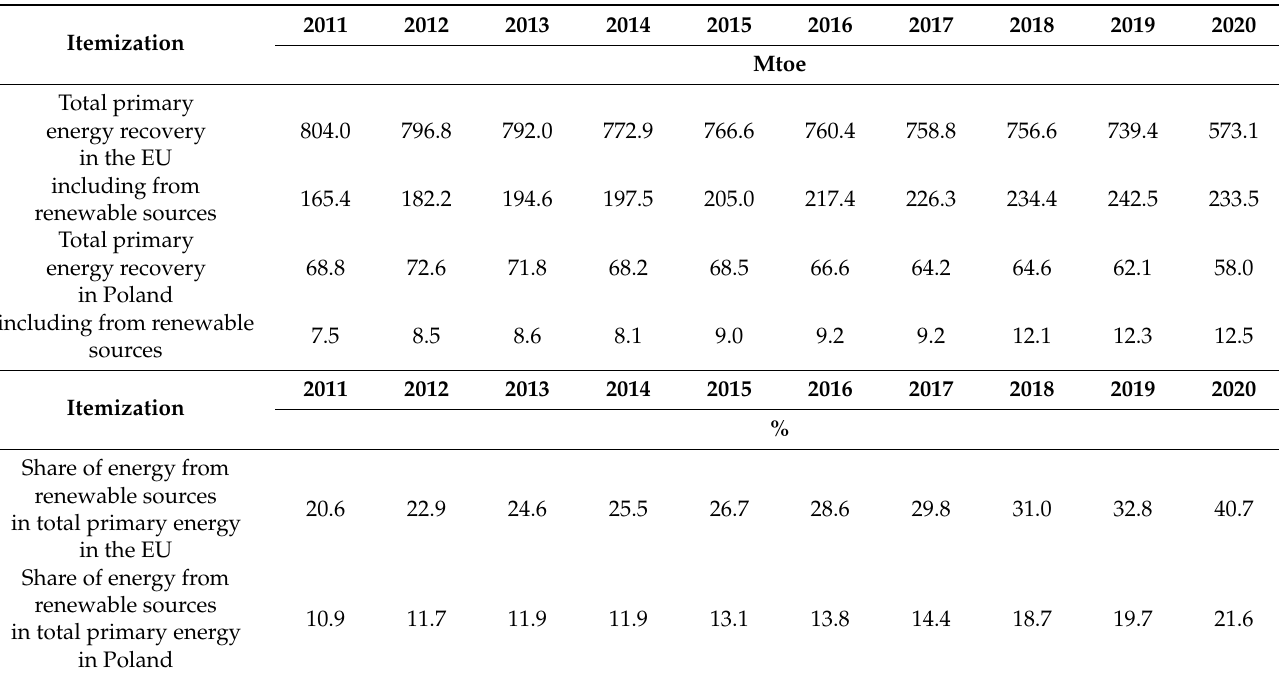
Table 18. Obtaining primary energy, including energy from renewable sources, in the European Union and Poland